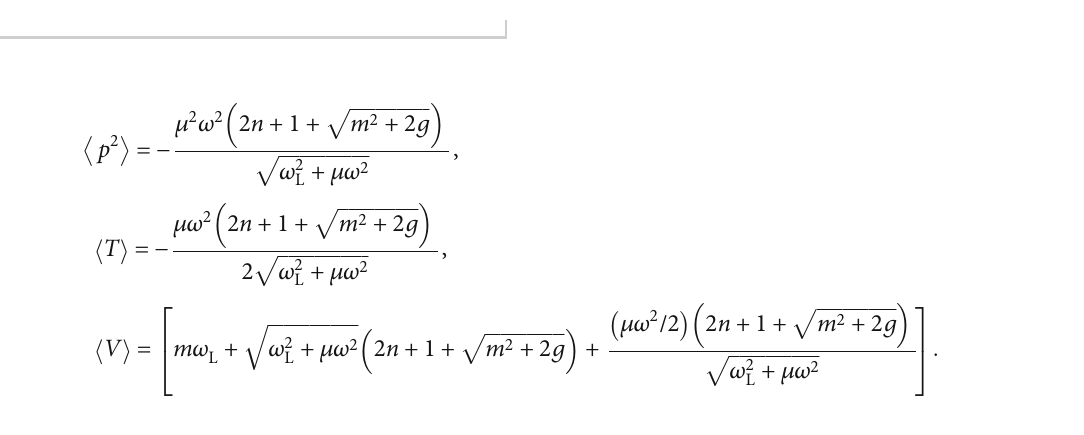
ffiffiffiffiffiffiffiffiffiffiffiffiffiffiffiffi ffiffiffiffiffiffiffiffiffiffiffiffiffiffiffiffiffiffi ω 2 + μω L